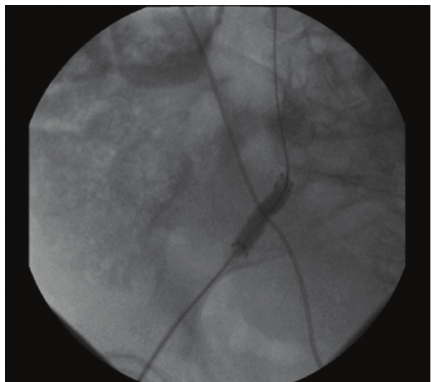
Figure 3: Vascular stent spanning the intersection of right iliac artery and